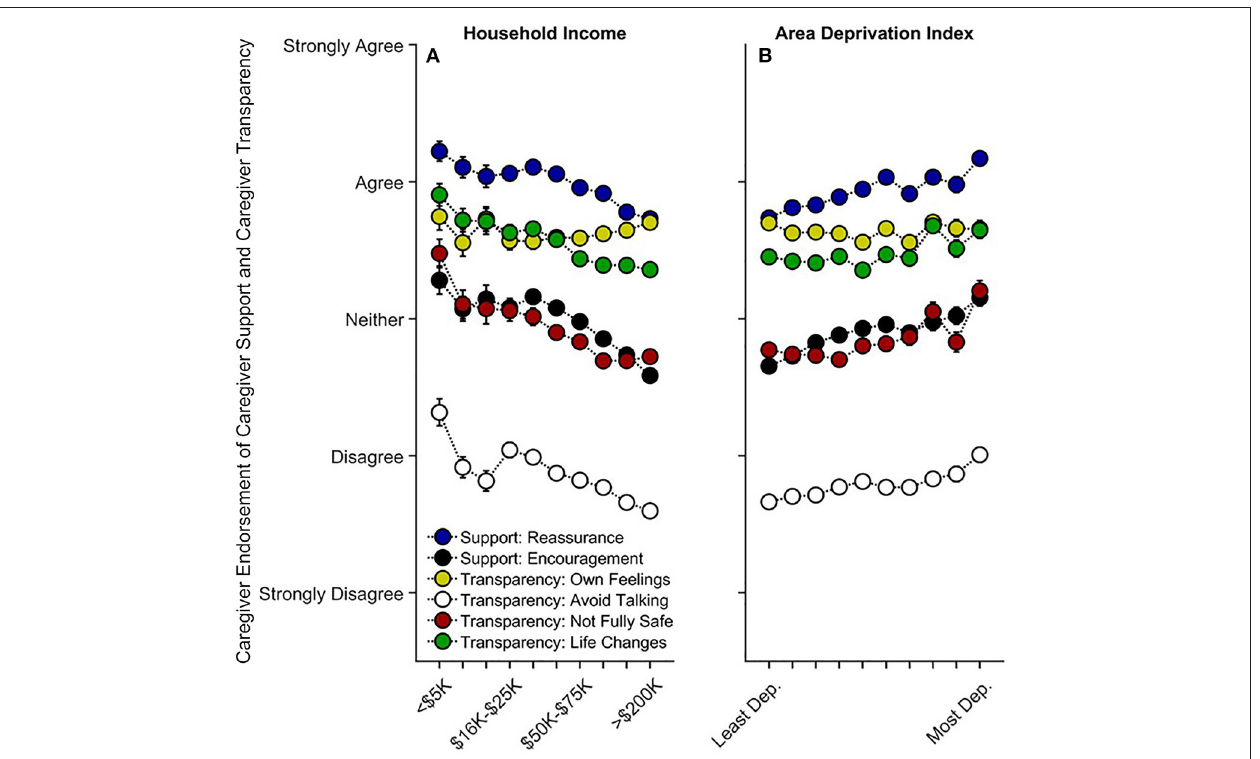
FIGURE 5 | Caregiver support and transparency as functions of (A) annual household income and (B) their home census tract’s area deprivation index. Error bars are ± 1 between-subjects standard error of the means. Analyses controlled for caregiver education, caregiver race, caregiver ethnicity, child sex, child age, questionnaire number, participants’ baseline study site, and participant. Caregiver “reassurance” refers to how much caregivers agreed with, “I have told my child that everything will be okay.” Caregiver encouragement refers to how much caregivers agreed with, “I have encouraged my child not to focus on coronavirus or its impacts on people and the world.” “Own Feelings” refers to how much caregivers agreed with “I discussed with my child my own feelings about coronavirus and its impact on people and the world.” “Avoid Talking” refers to how much caregivers agreed with, “I have avoided talking to my child about coronavirus.” “Not Fully Safe” refers to how much caregivers agreed with, “I have expressed concern to my child that they might not be fully safe from coronavirus.” “Life Changes” refers to how much caregivers agree with, “I have prepared my child for our lives to change significantly.” Area deprivation index was collapsed across continuous deciles for graphing. Dep.,